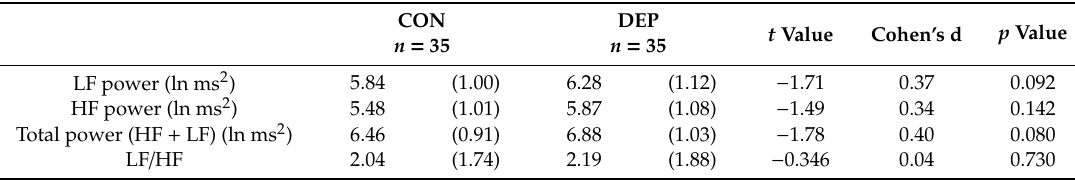
t Value Cohen’s d p Value